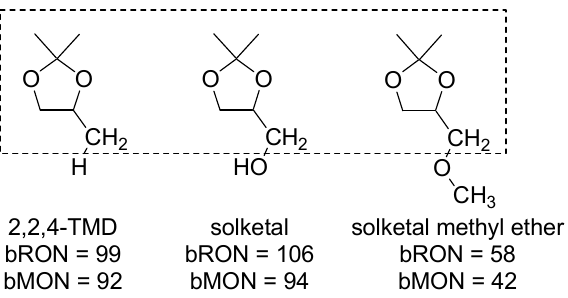
Figure 5. The molecular structure and the octane numbers of the 1,3-dioxolane derivatives. The octane numbers of solketal and solketal methyl ether were taken from the ref. [53].